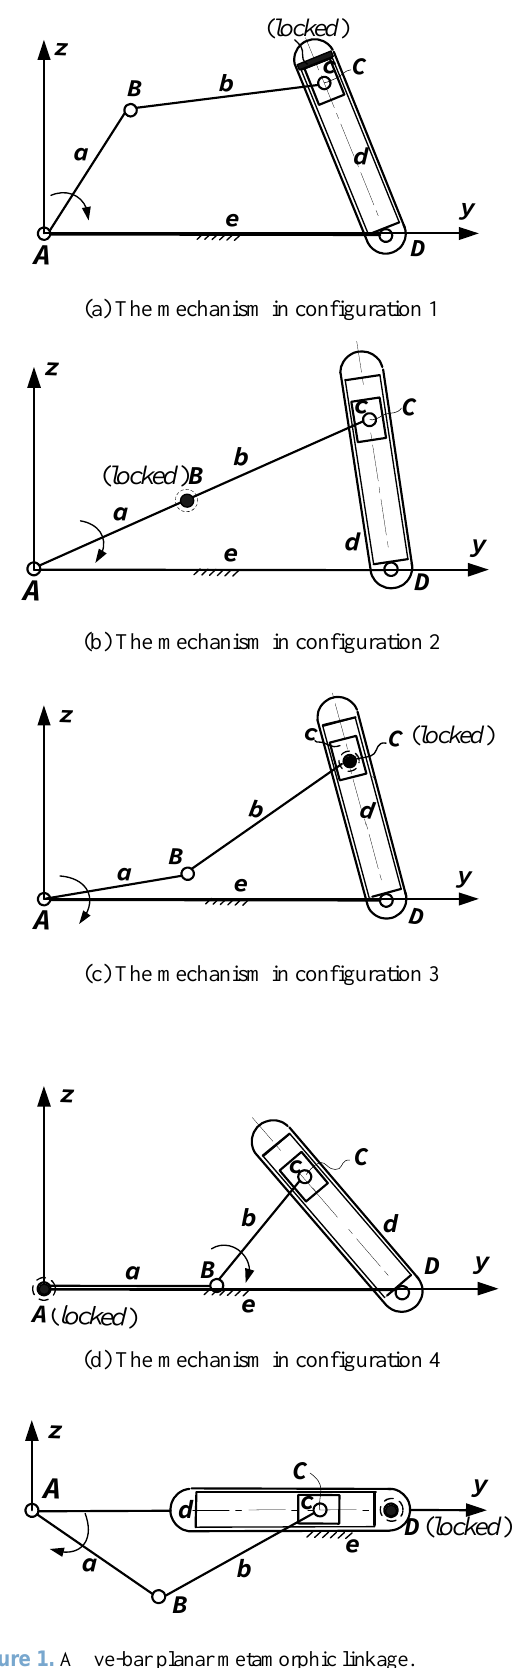
Figure 1. A five-bar planar metamorphic Fig. 1 A five-bar planar metamorphic linkage